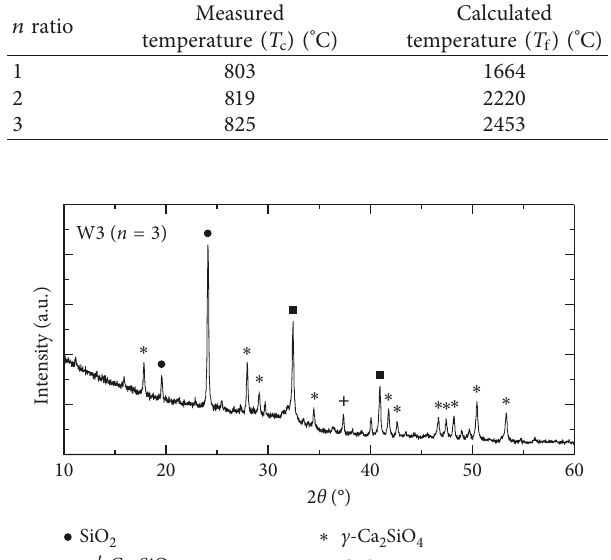
Table 1: Thermodynamic data employed in calculations [27]. Compound